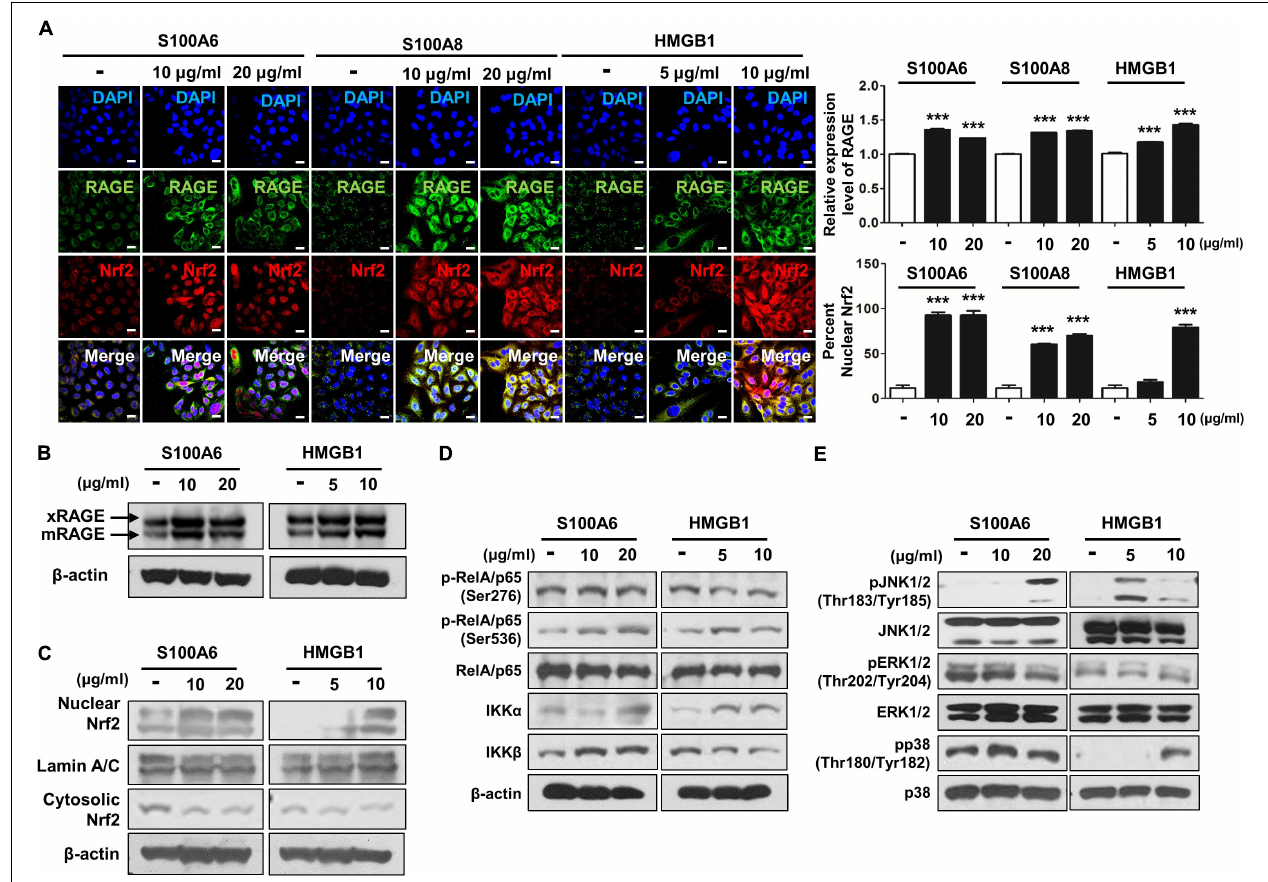
FIGURE 7 | The RAGE/ligand axis-induced activation of RAGE-mediated DAMP through Nrf2 nuclear migration in human alveolar epithelial cells. A549 cells were treated with S100A6 (10–20 µ g/ml), S100A8 (10–20 µ g/ml) and HMGB1 (5–10 µ g/ml) for 72 h. The expression of RAGE and the nuclear migration of Nrf2 were analyzed by immunocytochemistry and western blot. (A) The confocal images of RAGE expression and Nrf2 nuclear localization represent under conditions of RAGE ligands treatment. Quantification of RAGE expression was subjected to the number of RAGE-positive cells, and nuclear:cytoplasmic ratio of Nrf2 staining was subjected to densitometric analysis in chosen fields in three randomly at × 600 magnification. All values are average ± SE. ∗∗∗ p < 0.001 vs. no treatment. The protein levels of (B) membrane-bound RAGE (xRAGE and mRAGE) and (C) Nrf2 nuclear migration were analyzed by western blot. (D) The phosphorylation of RelA/p65 at serin 276 (Ser276) and serin 536 (Ser536), IKK α and IKK β were determined by western blotting with the appropriated antibodies in cell lysate. (E) The phosphorylation of JNK1/2 (Thr183/Tyr185), ERK1/2 (Thr202/Tyr204), and p38 (Thr180/Tyr182) MAPKs was detected with the represented antibodies. RelA/p65, β -actin, JNK1/2, ERK1/2, and p38 were used as loading control and the target protein bands were analyzed using ImageJ densitometry. All figures are representative of three independent experiments, performed in